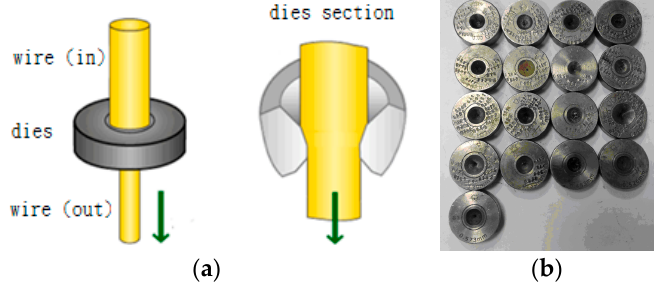
Figure 3. Profile of dies mold. ( a ) Dies; ( b ) dies molds.